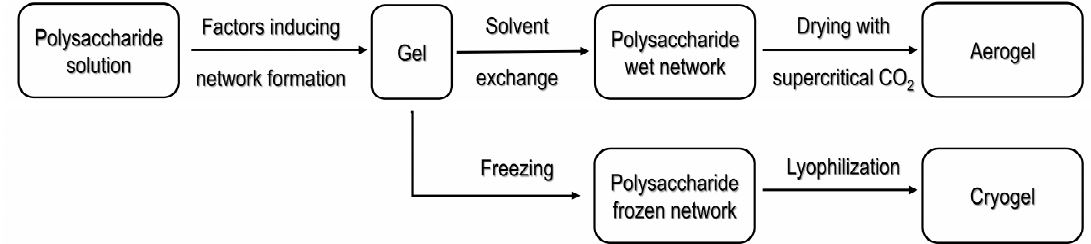
Figure 1. Pathway for porous materials produced by supercritical drying as well as freeze drying.